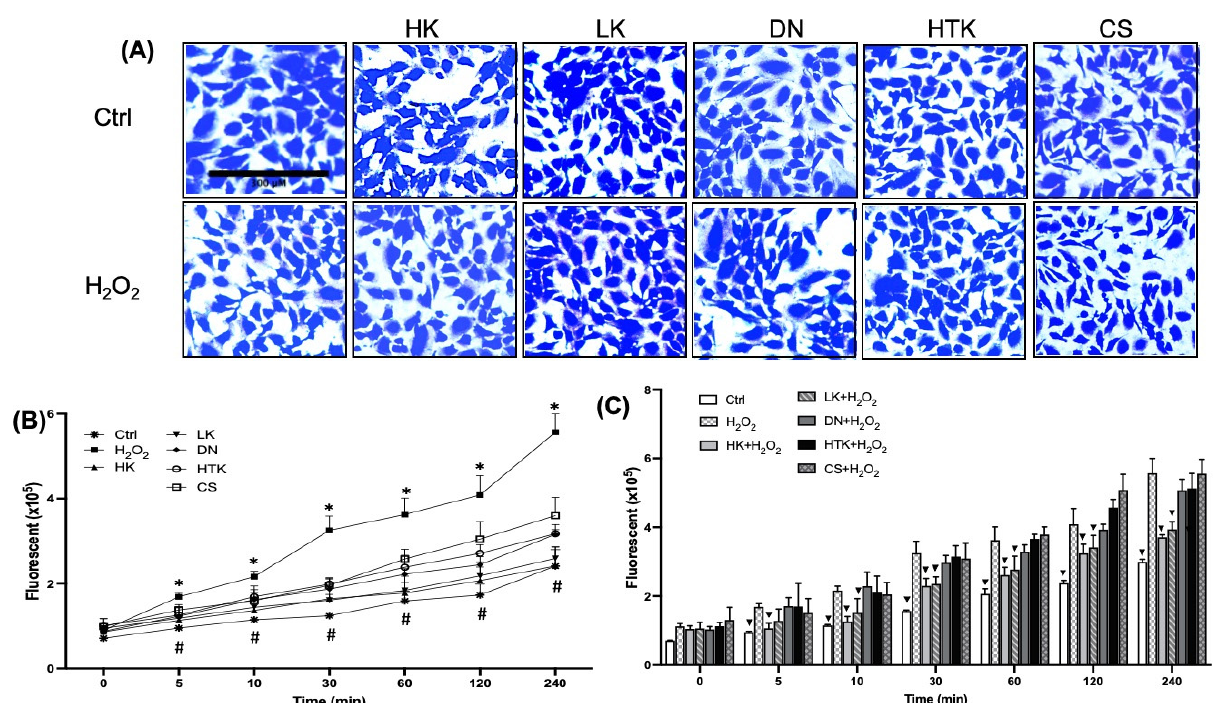
Figure 6. Effects of Cardioplegic Solutions on Cell Morphology and ROS Generation. AC16 cells were seeded in 6-well ( A ) or 96-well plates ( B , C ) for pretreatment with cardioplegic solutions for 3 h. After 1 h exposure to 200 µ M H 2 O 2 , cell morphology was recorded under an inverted light microscope after fixing and staining in 0.1% Coomassie blue ( A ). Following pretreatment with a cardioplegic solution, the cells were incubated with 100 µ M DCFH-DA for 30 min before recording ROS generation with 200 µ M H 2 O 2 treatment by a fluorescence microplate reader ( B , C ). The bar graphs represent the means ± SD from 4 replicates of one representative experiment ( C ). * indicates a significant difference ( p < 0.05) of H 2 O 2 -treated cells from Ctrl or a cardioplegic-solution-treated cells, whereas # indicates a significant difference ( p < 0.05) of Ctrl from DN-, HTK-, or CS-treated cells ( B ). indicates significant difference from H 2 O 2 -treated cells ( C ). These data were analyzed for the significant differences by one-way ANOVA using GraphPad Prism 9 software.